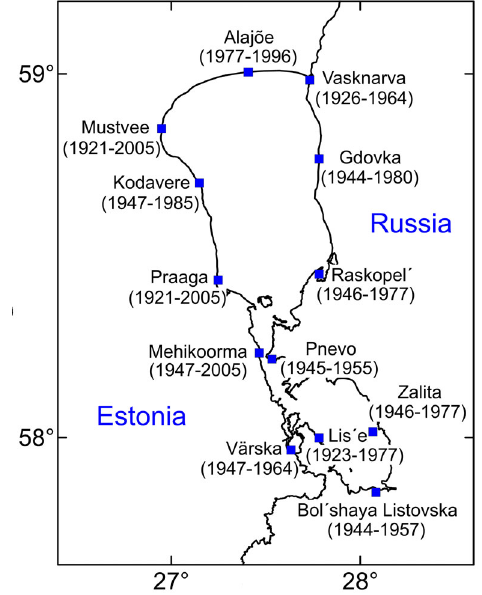
Fig. 3. Water gauges around Lake Peipsi (Fig. 1) and water level observation